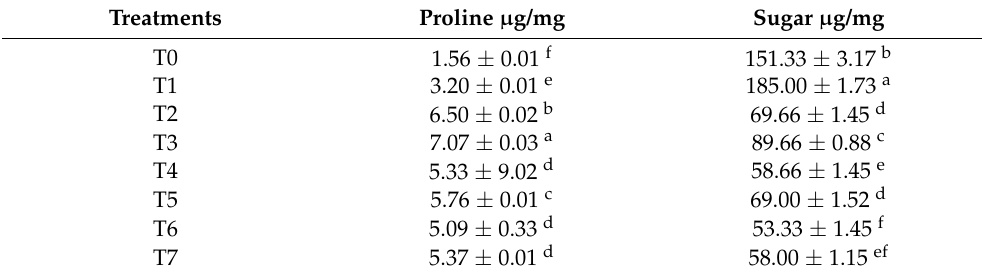
Table 4. Effect of chromium stress and B. cereus inoculation on osmolyte content of B.